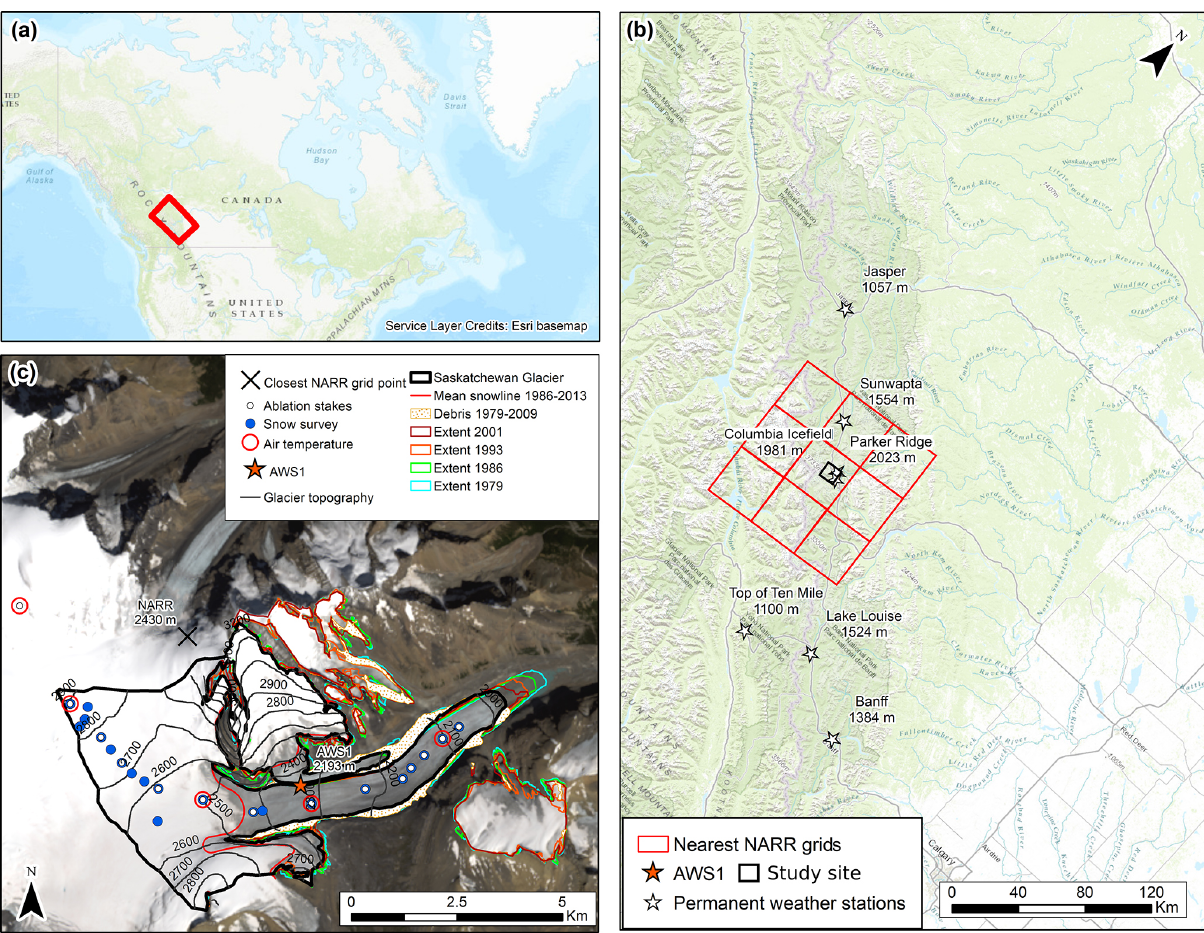
Figure 1. Study area map. (a) Location of the Columbia Icefield in the Canadian Rockies; the red rectangle shows the area of (b) . (b) Weather stations from the permanent network used to calculate temperature and precipitation lapse rate. The nine NARR grid cells closest to Saskatchewan Glacier are shown as red squares. (c) Map of Saskatchewan Glacier showing the location of ablation stakes and additional snow survey points, as well as air temperature sensors used to determine the diurnal lapse rate over the glacier. The mean end of summer snow line position (1986–2013) is shown with a red line. A Landsat 8 scene from 22 August 2013 is used for the map